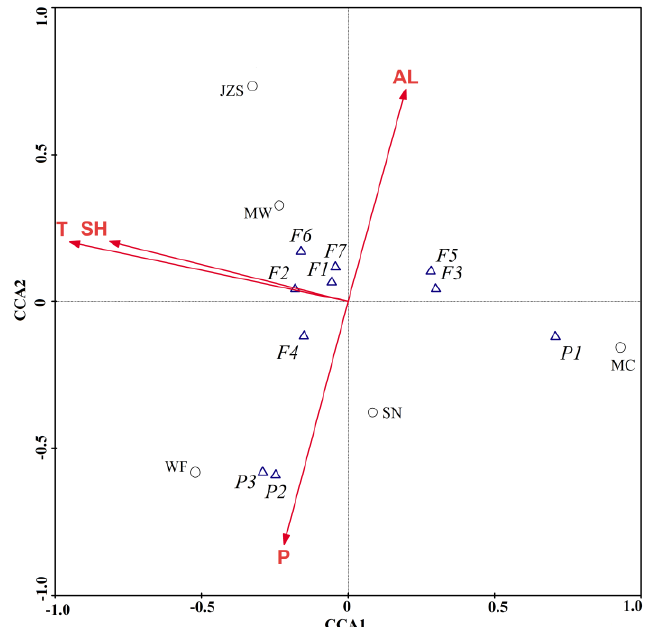
Figure 2. Canonical correspondence analysis biplot of C. paliurus phenolics, linking contents of the individual components, geographical locations (JZS, MC, WF, MW, and SN) and their bioclimatic indices. T: mean annual temperature; SH: mean annual sunshine hours; AL: altitude; P: mean annual